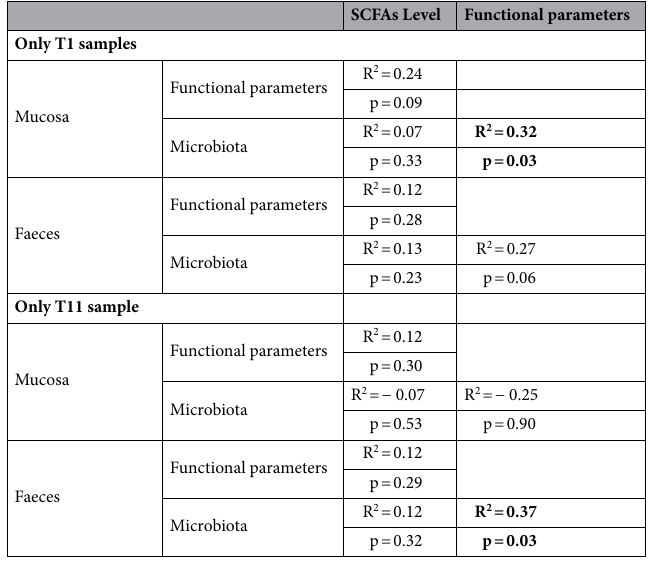
Table 2. Spearman correlation coefficients (R 2 ) and significance (p-value) of mantel tests between Bacteria community structure (Bray–Curtis distance) and SCFAs (acetic, propionic, butyric, iso-butyric, iso-valeric, 2-methyl-butyric, valeric, hexanoic) or mucosal functional parameters (PCNA, CD68, DClK1, Apoptosis, MUC2). Statistically significant values (p < 0.05) are highlighted in